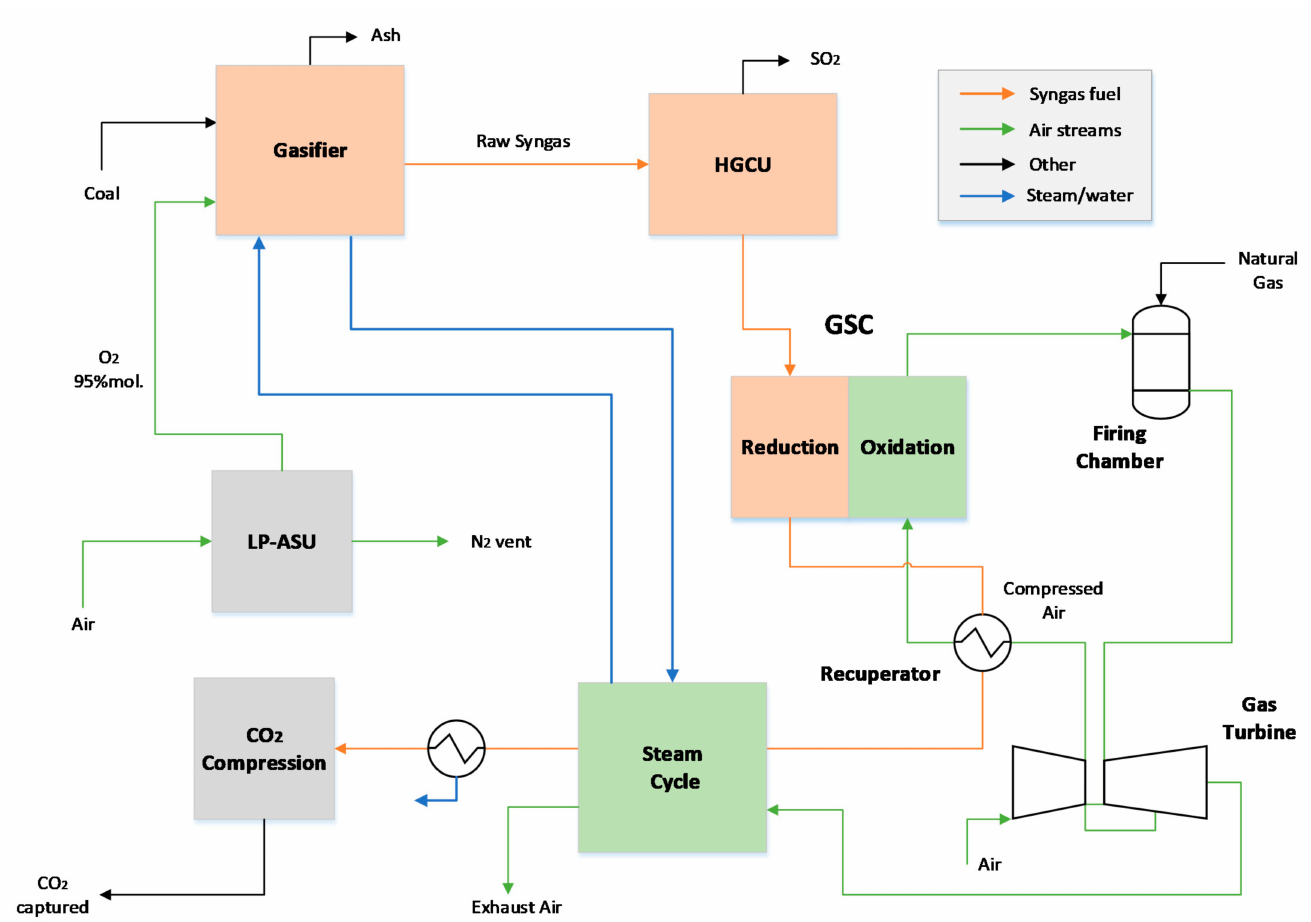
Figure 3. Schematic of GSC+AF power plant (Case 4)